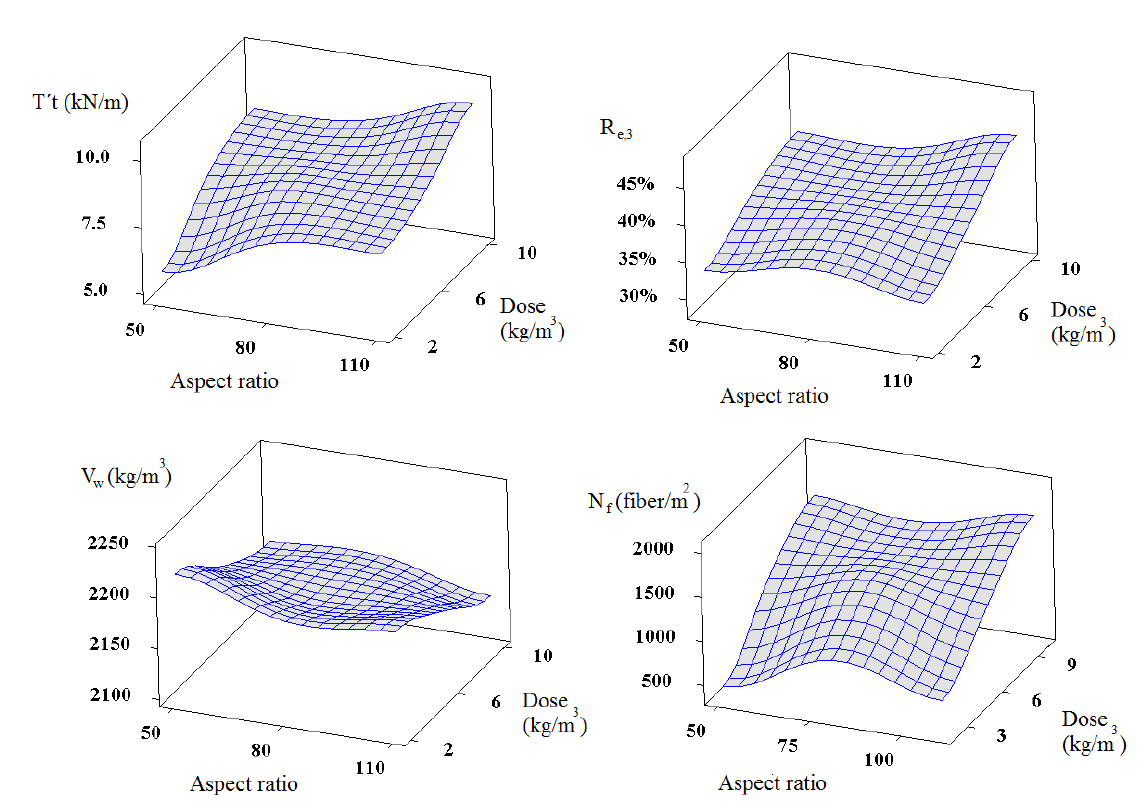
Figure 20. Surface graphs of fibre reinforced concrete (FRC) with recycled PET fibre.